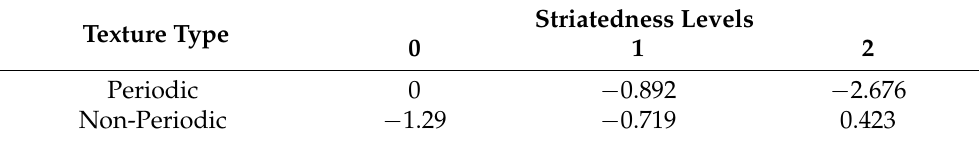
Table A2. Interaction log odds of Texture & Striatedness.